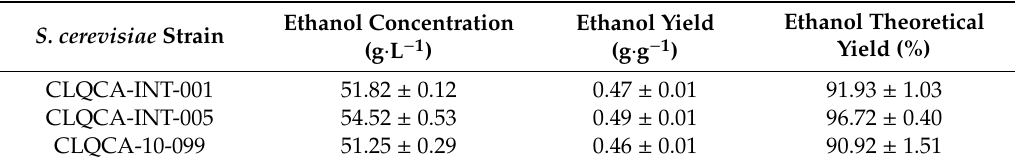
Ethanol yield of di ff erent S. cerevisiae strains: CLQCA-INT-001, INT-005-CLQCA and